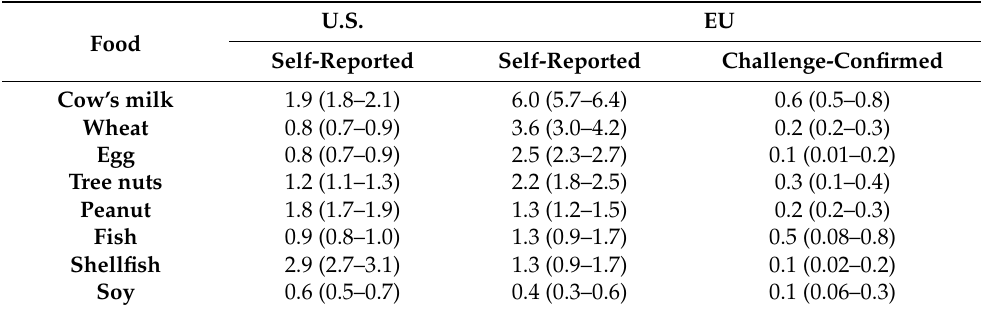
Table 2. Prevalence (%) of the eight most common food allergens in adults in the U.S. and the EU [3,21]. Numbers shown represent the average (95% CI) of data collected at centers in different